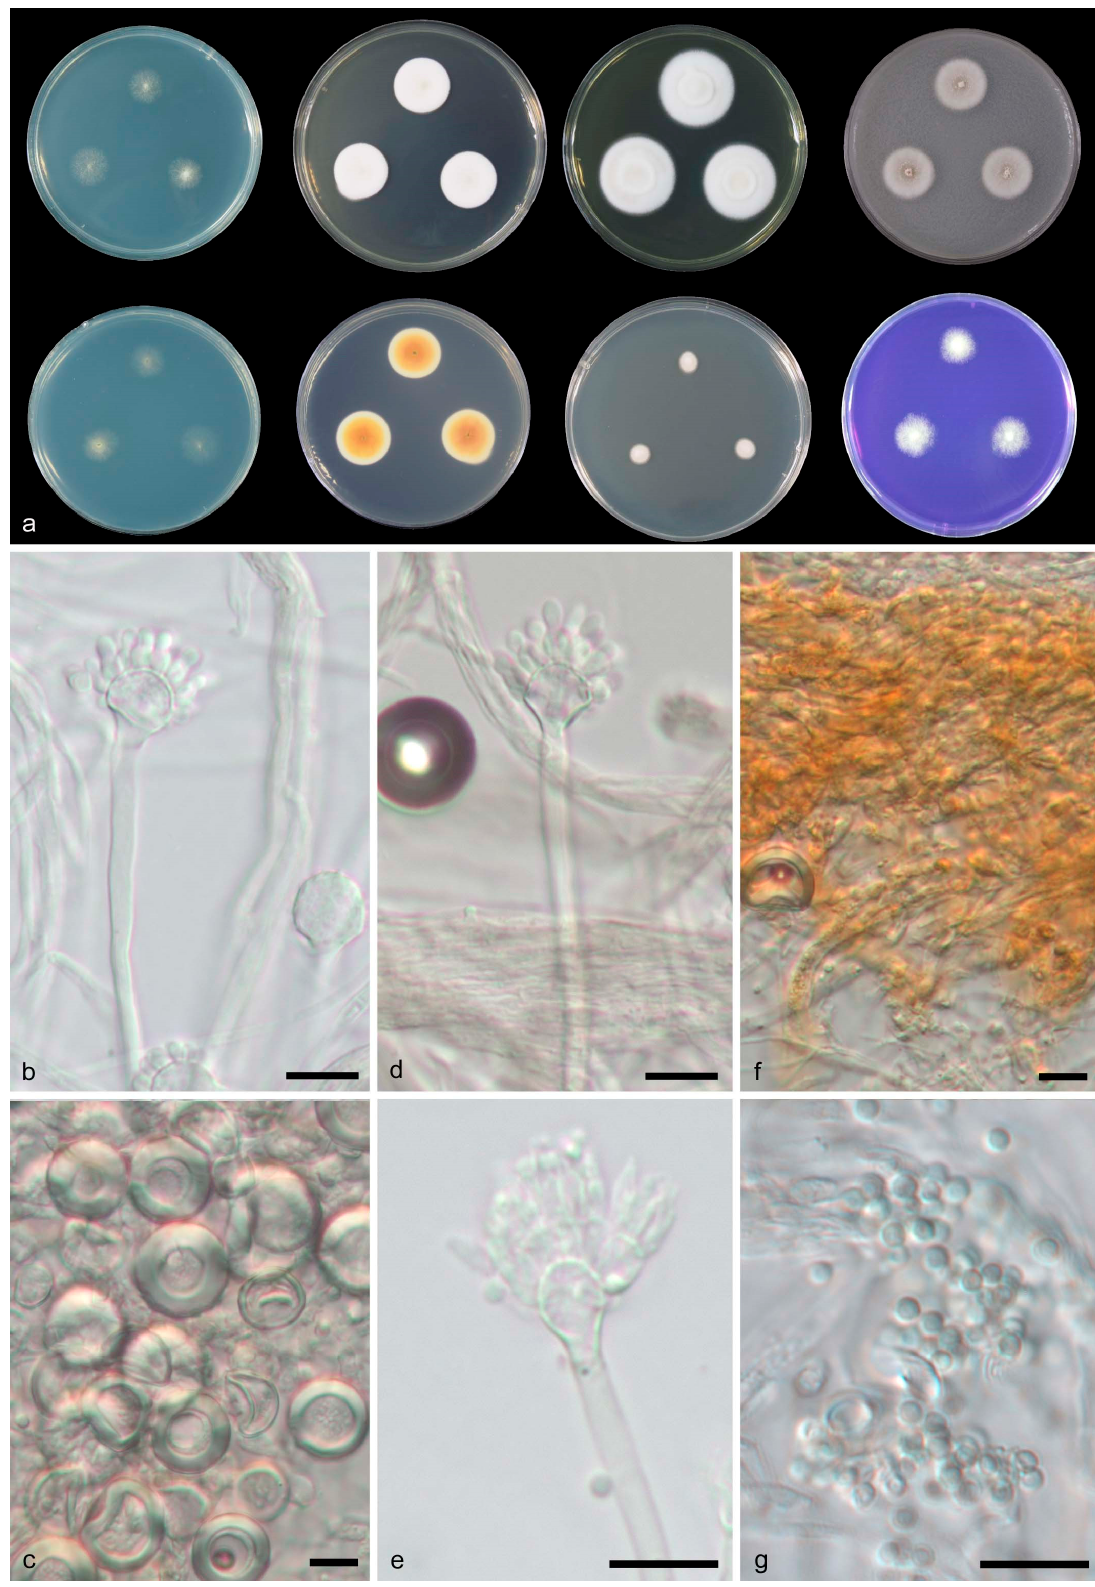
Figure 5. Aspergillus tibetensis CGMCC 3.19707 T. ( a ) Colonies: top row left to right, obverse CYA, obverse MEA, YES and OA; bottom row left to right, reverse CYA, reverse MEA, DG18 and CREA. ( b , d – f ) Conidiophores. ( c ) Hülle cells. ( g ) Conidia. Scale bars: b–g = 10 μ m.